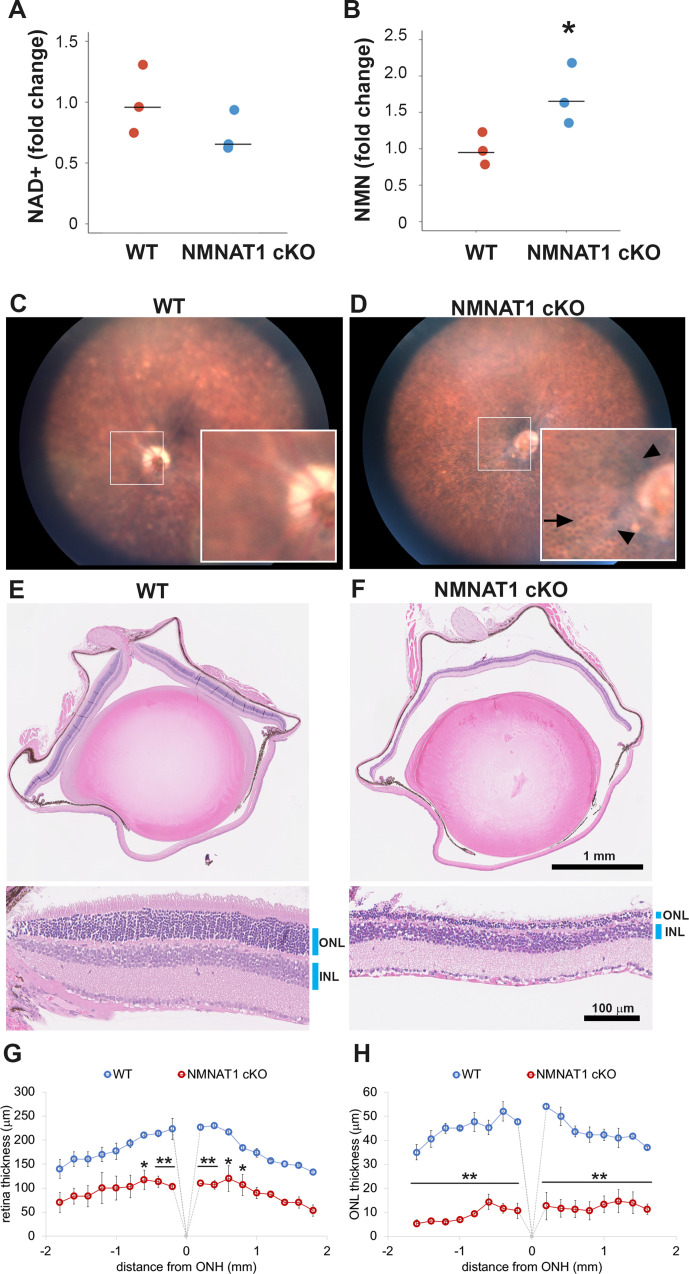
NMNAT1 depletion induces severe retinal degeneration.(A, B) Metabolite analysis by LC-MSMS in retinal tissues from WT or NMNAT1 conditional knockout (Nmnat1fl/fl: CAG-CreERT2 + tamoxifen: NMNAT1 cKO) mice at 25 days post tamoxifen injection. Fold changes of NAD+ (A) and NMN (B) concentrations compared with that of WT retinal tissues are shown. *p<0.05 denotes the significant difference from WT with Kruskal-Wallis test (n = 3 mice for WT and n = 3 mice for NMNAT1 cKO). Graphs show the all data points and median (cross bars). (C, D) Fundus biomicroscopy images of the retina from wild type (WT, C) or NMNAT1 conditional knock out (Nmnat1fl/fl: CAG-CreERT2 + tamoxifen: NMNAT1 cKO, D) mice at 4 weeks post tamoxifen injection. (E, F) representative images of hematoxylin and eosin stained eye sections from WT mice (E) or NMNAT1 conditional knockout (Nmnat1fl/fl: CAG-CreERT2 + tamoxifen: NMNAT1 cKO, E) mice at 4 weeks post tamoxifen injection (ONL: outer nuclear layer and INL: inner nuclear layer). The substantial thinning of the ONL was observed in 3 WT and 3 NMNAT1 cKO mice. (G) The quantification of the retina thickness from WT and NMNAT1 conditional knockout (Nmnat1fl/fl: CAG-CreERT2 + tamoxifen: NMNAT1 cKO) mice were shown. Graphs show the average and error bars represent the standard error. Statistical analysis was performed by two-way ANOVA with Tukey post-hoc test (n = 3 mice for WT, n = 3 mice for NMNAT1 cKO (Nmnat1fl/fl: CAG-CreERT2 + tamoxifen at 4 weeks post tamoxifen injection)). F(1, 72)=309, p<1.0×10−16 between WT and NMNAT1 cKO retina. *p<0.05 and **p<0.001 denotes the significant difference compared with WT retina. (H) The quantification of the ONL thickness from WT and NMNAT1 conditional knockout (Nmnat1fl/fl: CAG-CreERT2 + tamoxifen: NMNAT1 cKO) mice were shown. Graphs show the average and error bars represent the standard error. Statistical analysis was performed by two-way ANOVA with Tukey post-hoc test (n = 3 mice for WT and n = 3 mice for NMNAT1 cKO). F(1, 72)=1023, p<1.0×10−16 between WT and NMNAT1 cKO retina. **p<0.001 denotes the significant difference compared WT.Figure 1—source data 1.Source data for Figure 1.